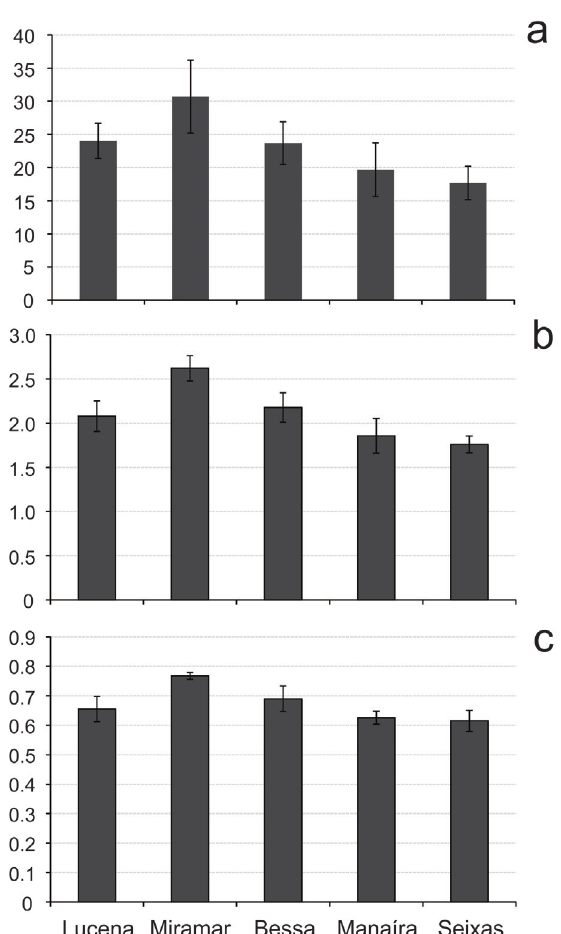
Figure 3. Spatial variation of the mean number of species (a), diversity of Shannon-Winner (b) and Pielou’s equitability (c) of dead foraminiferan assemblages from João Pessoa metropolitan area. Lowercase letters indicate the result of the Tukey a posteriori test; beaches sharing at least one letter do not differ significantly (p>0.05) from each other. Error bars represent the standard